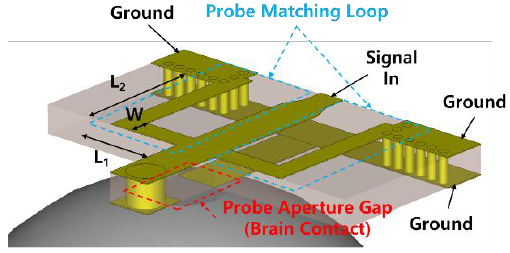
Figure 6. Structure of the proposed probe for E-field focusing and matching to the brain.